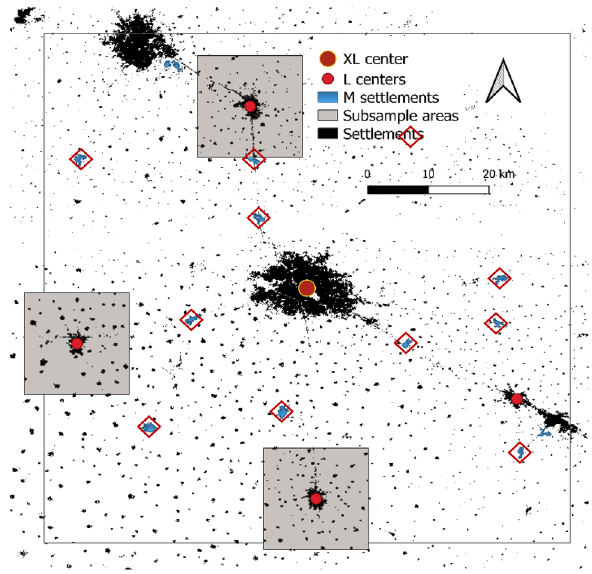
Figure 8. Subsample for comparison of mapped settlement sizes with data extracted from CityPopulation database for the Punjab in N-India. M settlements included in the analysis are marked by red diamonds (Settlement binary map of